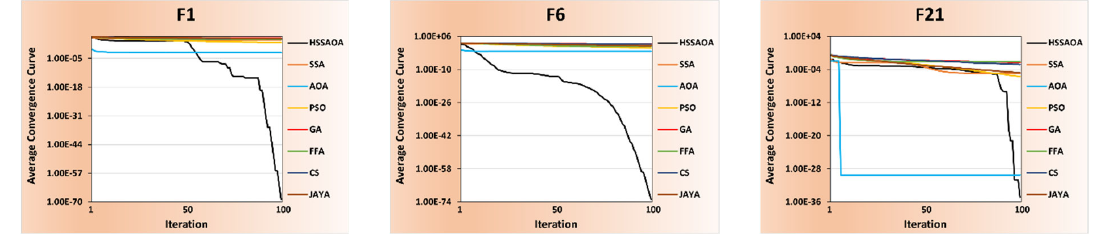
Fig. 4 Logarithmic convergence curve of some functions according to Group 1